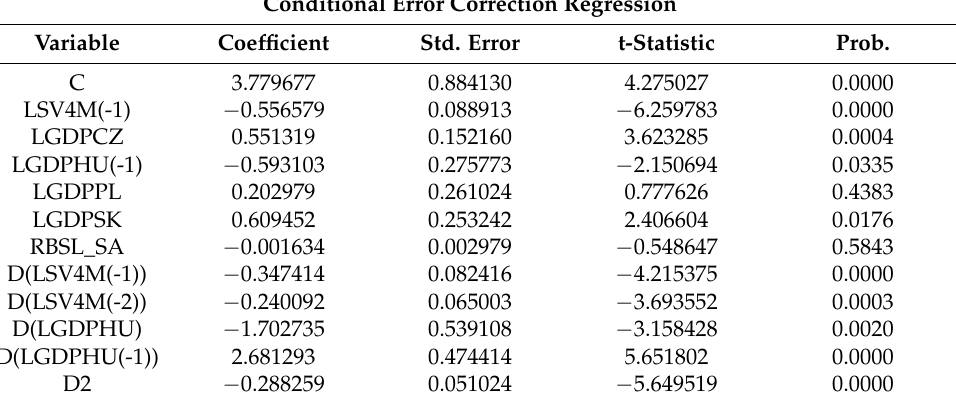
Table A3. Stable Import Model of Slovakia (D1 is